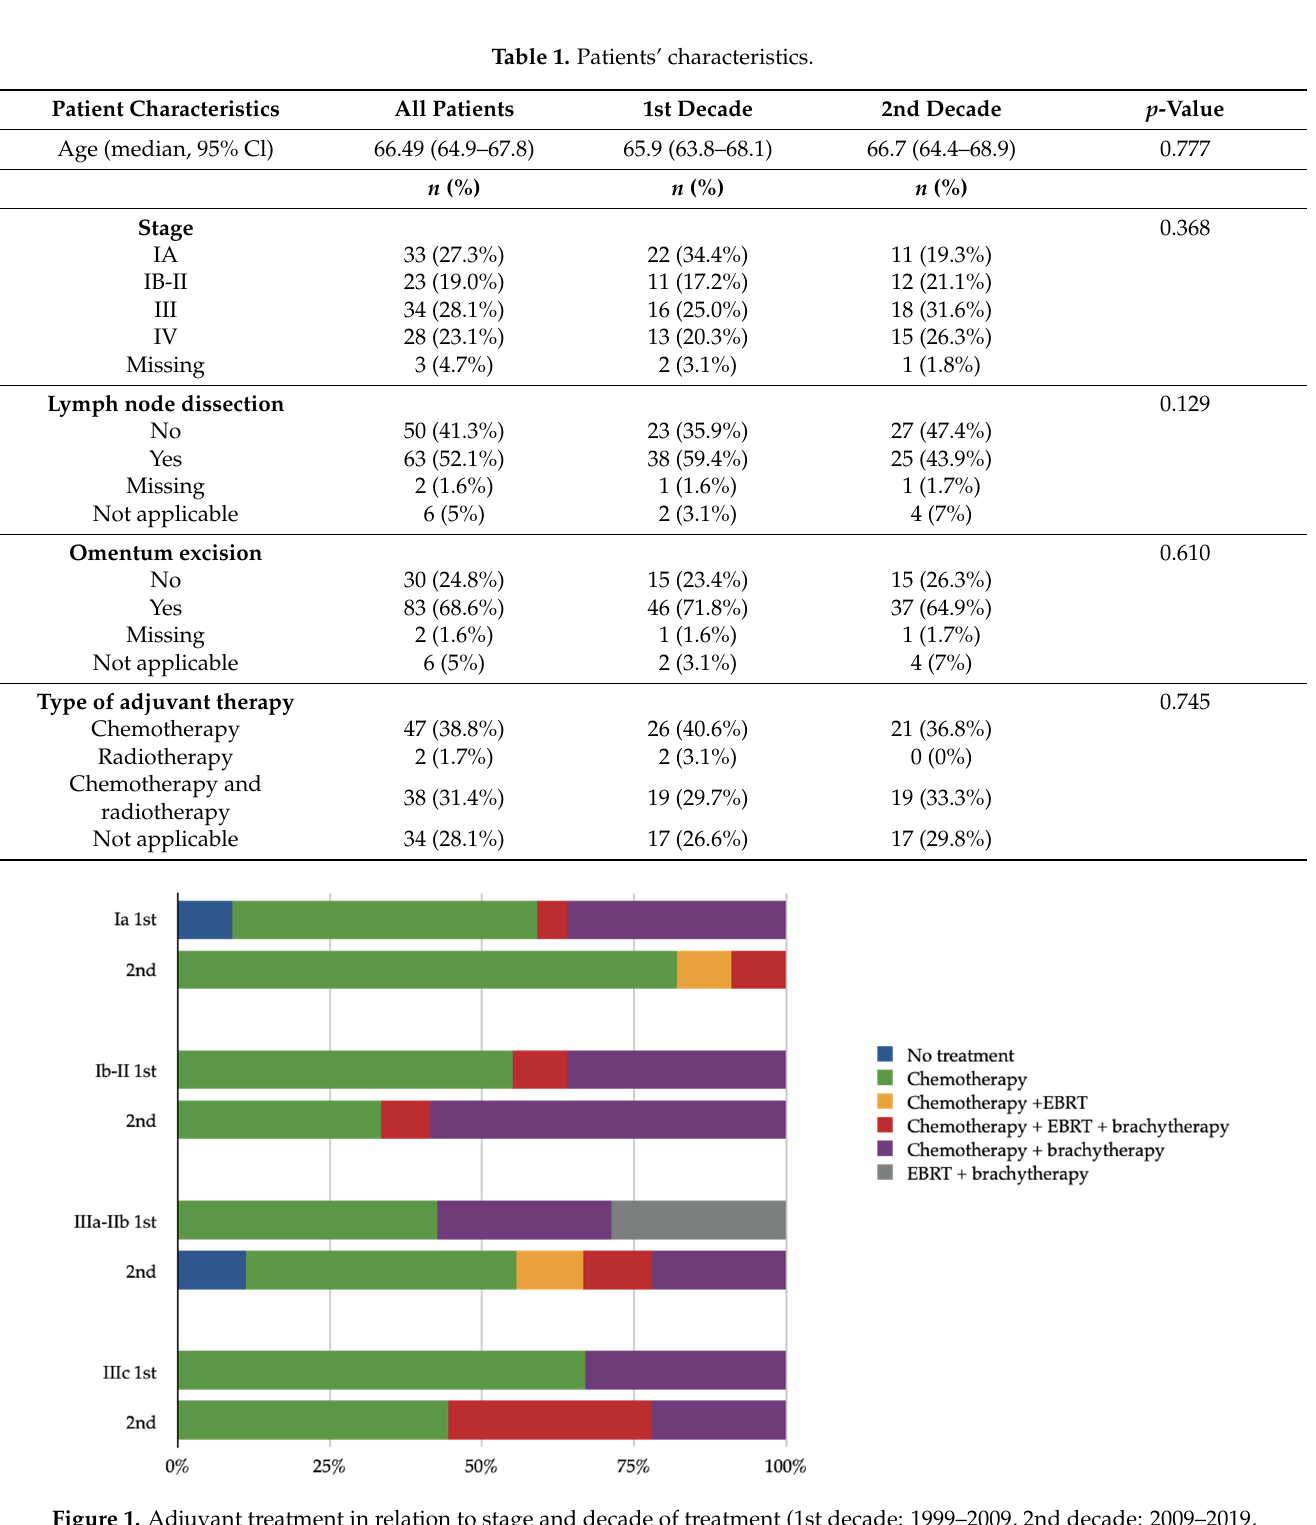
Figure 1. Adjuvant treatment in relation to stage and decade of treatment (1st decade: 1999–2009, 2nd decade: 2009–2019, EBRT: external beam radiotherapy).